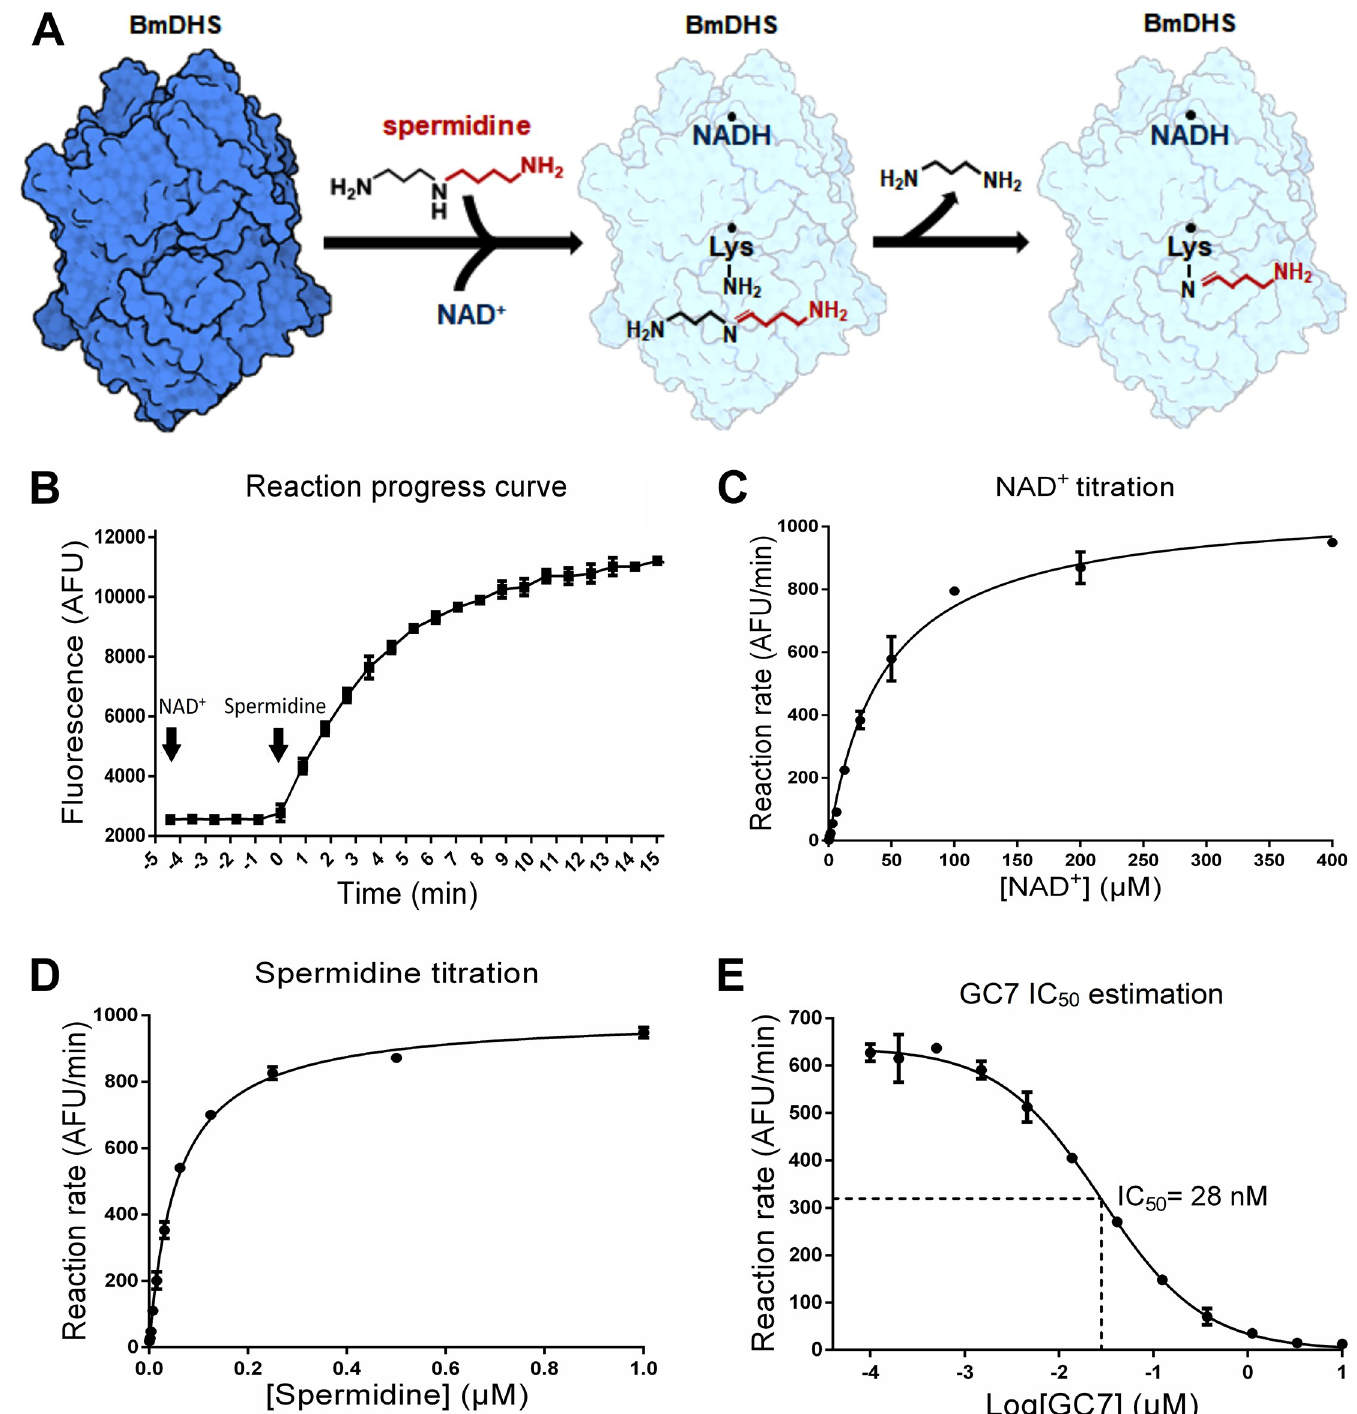
Fig 5. Partial reaction mechanism, establishment of a NAD + /NADH fluorescence enzymatic assay for the BmDHS partial reaction, and IC 50 determination for GC7. (A) Proposed reaction mechanism for a single turnover catalyzed by BmDHS in the presence of NAD + and spermidine. Maintenance of the covalent adduct between BmDHS Lys326 and the butylimine group from spermidine keeps the enzyme in an inactive form. In the absence of eIF5A, DHS is not regenerated. (B) Reaction progress curve demonstrating the generation of NADH by BmDHS. Fluorescence emission intensity after excitation at 355 ± 15 nm. The final component of the reaction was added to the plate at time 0 and the fluorescence intensity was measured during the indicated time. The reaction (50 μ L) was composed of 100 nM BmDHS, 132 μ M NAD + and 0.5 μ M spermidine. (C) Titration of NAD + . Variable concentrations of NAD + (0.195 to 400 μ M) and fixed concentrations of BmDHS (100